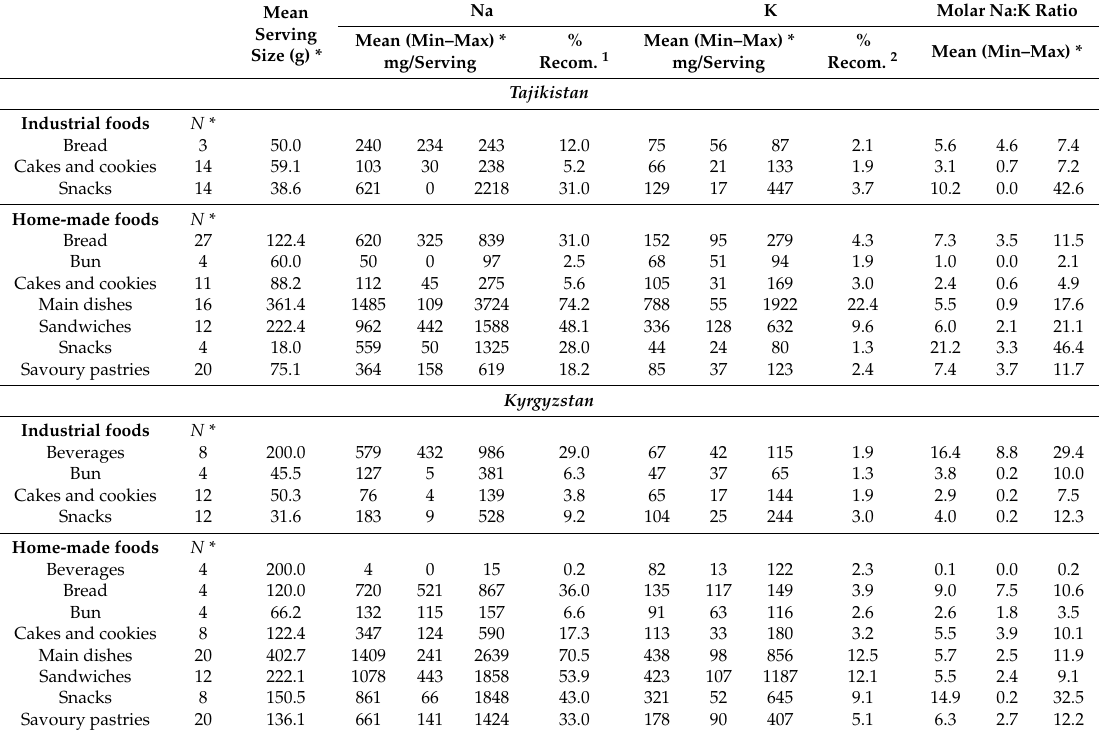
Table 1. Sodium (Na) and potassium (K) content and molar Na:K ratio in different groups of the most commonly available street foods in Tajikistan and